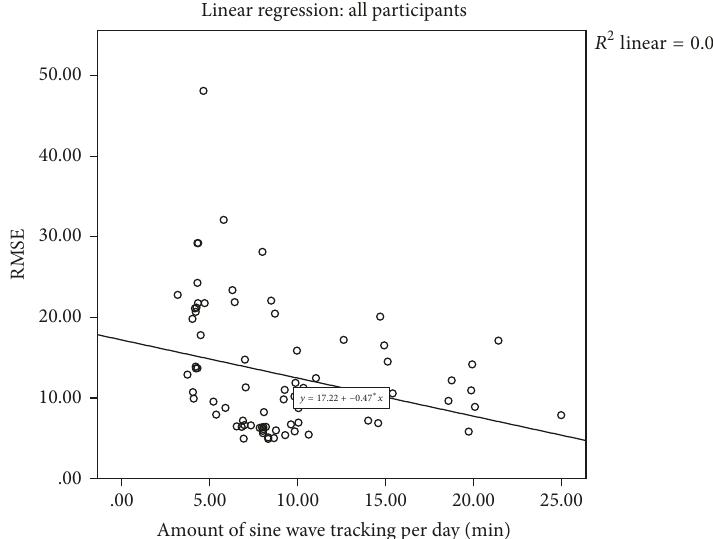
Figure 6: Preliminary dose-response relationship between RMSE and daily sine wave practice time. Linear regression models exploring preliminary dose-response relationship between RMSE and daily sine wave practice time for all